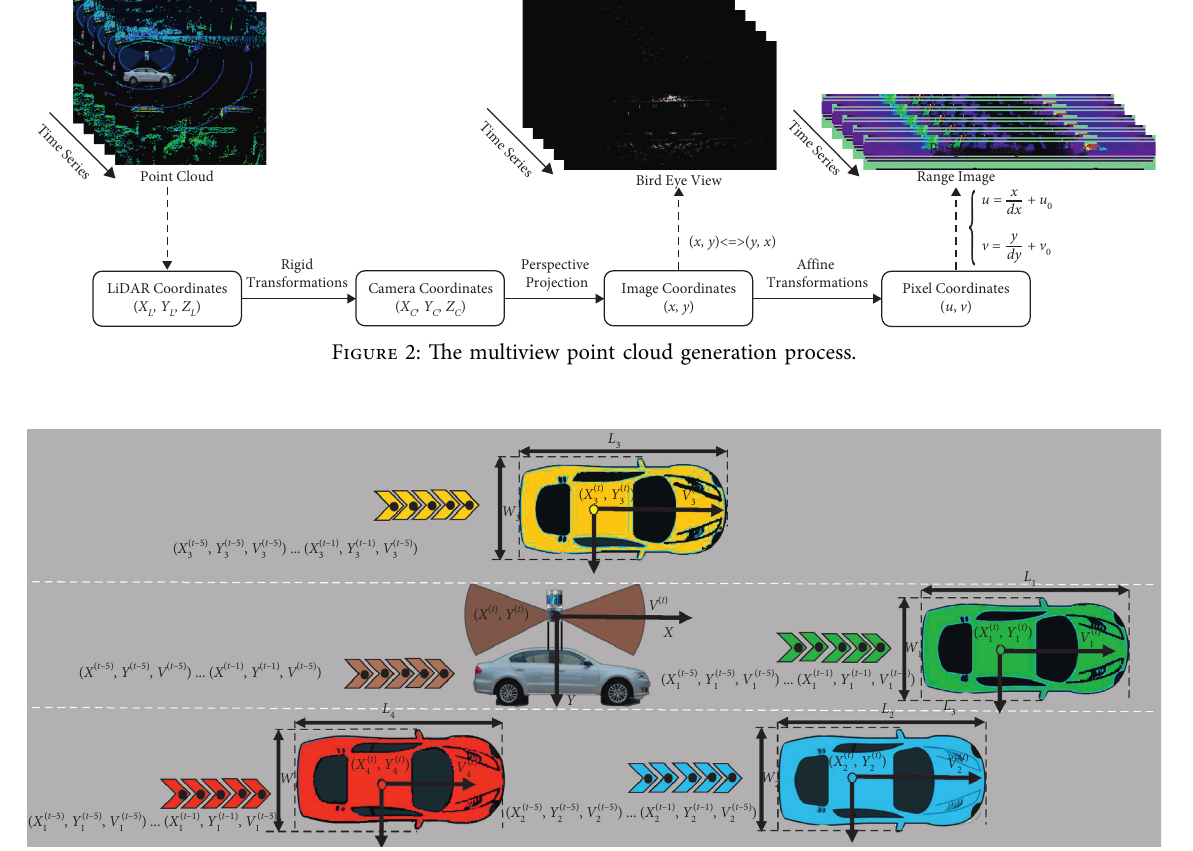
Figure 3: A multitarget information interaction network in a complex traffic scene.